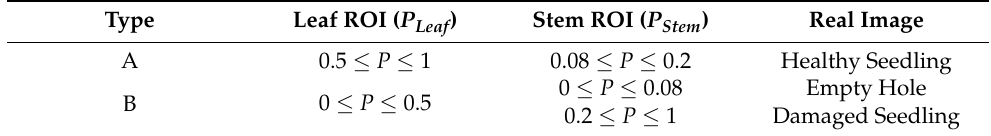
Table 2. Function